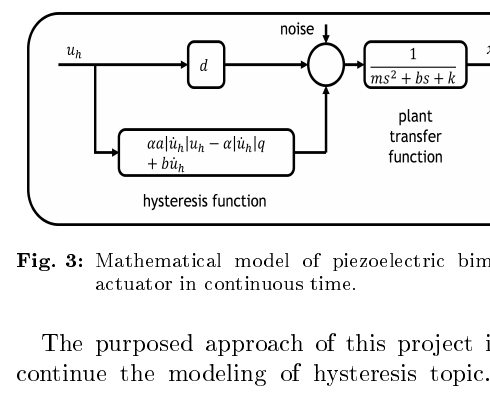
where k represents the k th time step. Therefore,